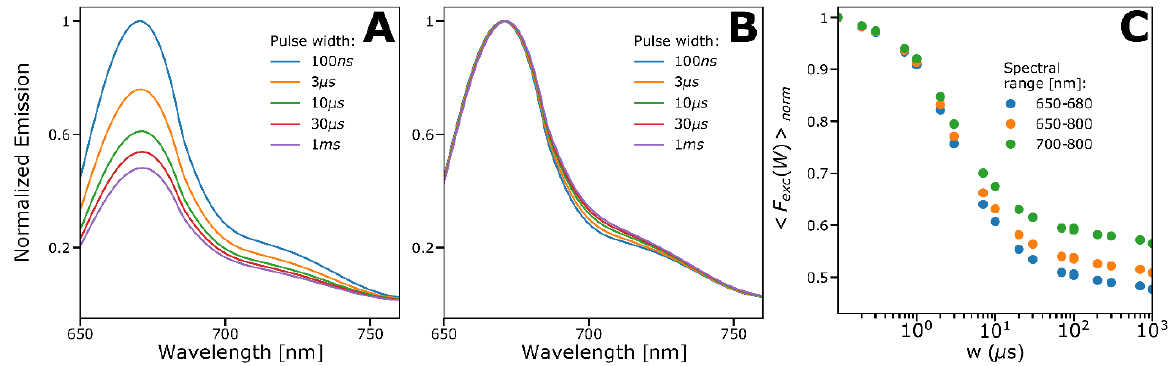
Figure 5. Spectral-TRAST measurements of Cy5 in PBS solution (12 mM, pH 7.2) at 638 nm excitation. The spectra in ( A – B ) are measured at Φ 𝑒𝑥𝑐 = 3.9 kW/cm² using excitation pulse trains with a constant duty cycle of 0.002 and with different pulse widths, w . ( A ) Emission spectra obtained for different w (specified in legend), normalized with the emission maximum retrieved at 100 ns. ( B ) Emission spectra obtained for different w (specified in legend), normalized with the emission maximum for each curve. ( C ) TRAST curves generated from fluorescence within different spectral win- dows of the spectra in ( A ) and with the different spectral windows specified in the legend. The TRAST curves were normalized so that the fluorescence intensity recorded with w = 100 ns within the different spectral windows (blue curve in ( A )) was set to unity.